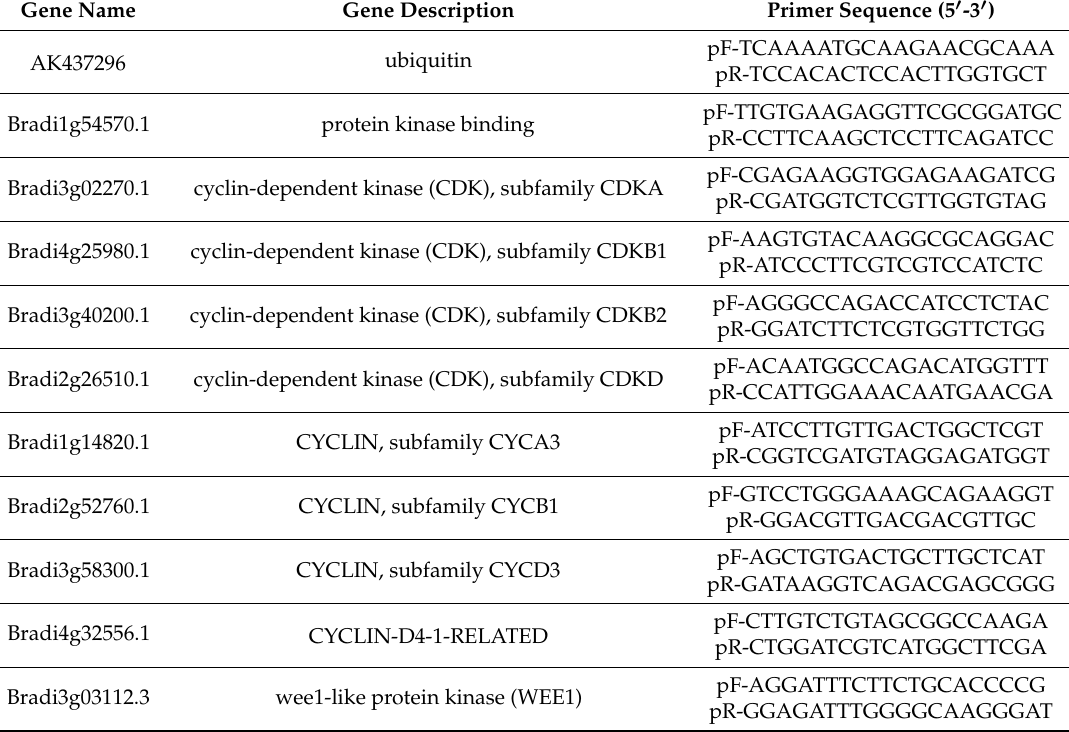
Table 2. The oligonucleotide primers that were used for the RT-PCR reaction with the relevant description of the